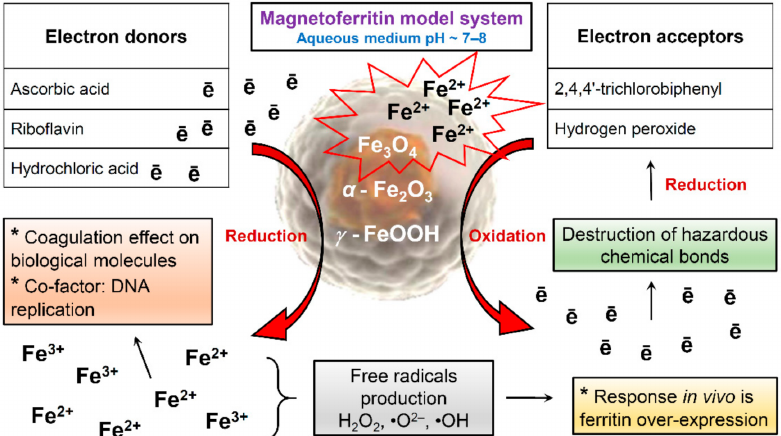
Figure 8. Schematic illustration of magnetoferritin redox reactions during various interactions. Ascorbic acid and riboflavin, as electron donors, can reduce ferritin and the